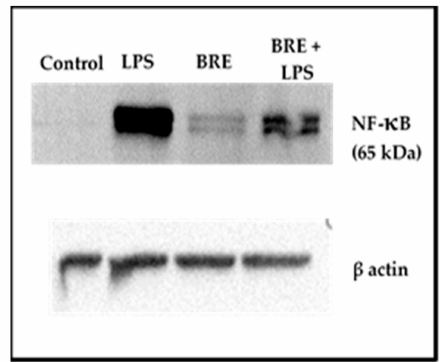
Figure 6. BRE increased NF- κ B p65 in PBMCs. Cells were incubated with BRE (0, or 50 µ g / mL) and stimulated with LPS (1 µ g / mL) for 1